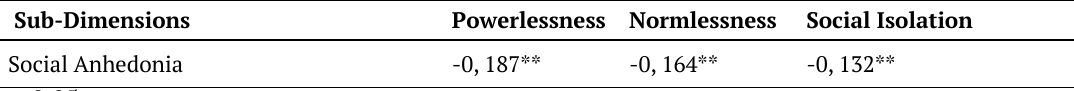
Table 7. Pearson correlation table between RSAS and DAS sub-dimensions Sub-Dimensions Powerlessness Normlessness Social Isolation Social Anhedonia -0, 187** -0, 164** -0, 132**